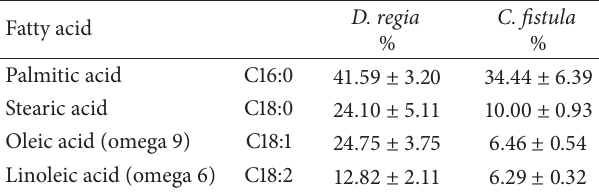
Table 2: Fatty acid profile of D. regia and C. fistula seed extracts.